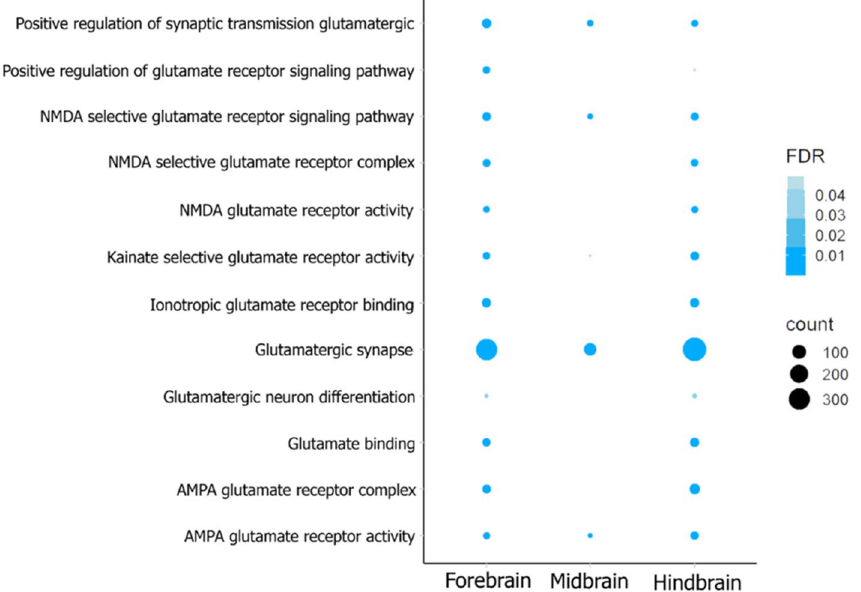
Figure 4. Functional enrichment of Gene Ontology (GO) terms related to the Glutamatergic synapse pathway in L. dimidiatus individuals in the Fore, Mid and Hindbrain. The enrichments are based on differentially expressed genes of the comparison control vs interaction. The size of the circles is proportional to the number of genes observed within each GO category, and the colour of the circles is proportional to the significance (FDR